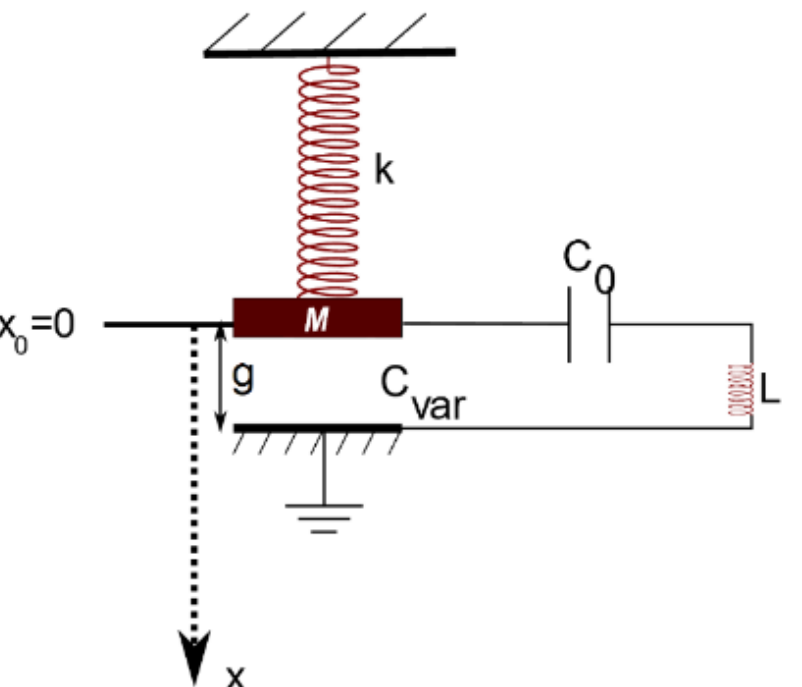
Figure 1. The coupled mechanical–electrical oscillators.